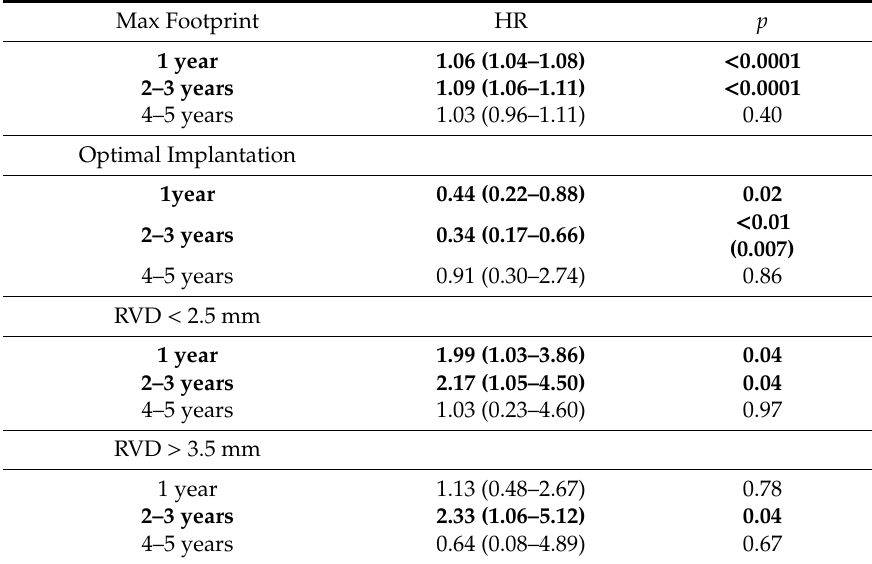
Table 2. Predictors of TLF in univariate Cox regression analysis during di ff erent time intervals of follow-up duration. HR: Hazard ratio. RVD: reference vessel diameter. Bold character identifies parameters associated with p values <